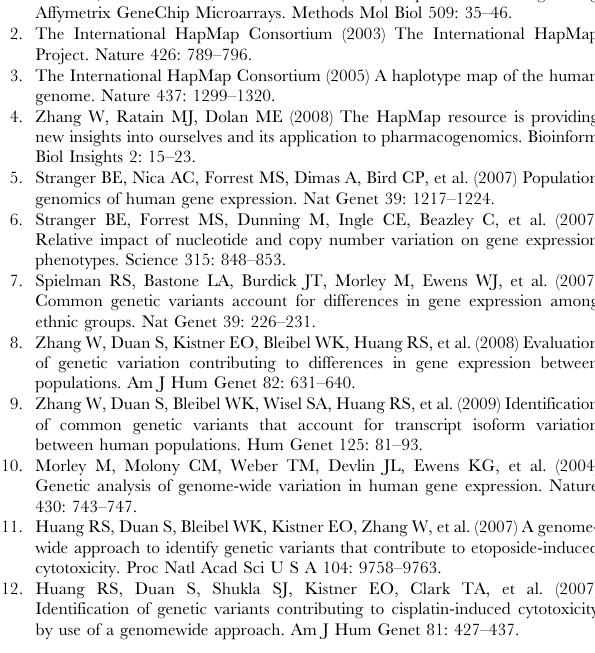
Figure S1 Chromosomal distribution of affected core-level probesets in the exon array. Blue indicates the CEU samples; Red indicates the YRI samples. Common SNPs (MAF . 0.05) are included. MAF: minor allele frequency. Table S1 Chromosomal distribution of all SNPs in the exon array. Table S2 Functional annotations of all SNPs in the exon array. Table S3 SNP-containing probesets based on the 1000 Ge- nomes Project genotypic data. Table S4 A list of SNP-containing probesets (exon-level) for the CEU samples.